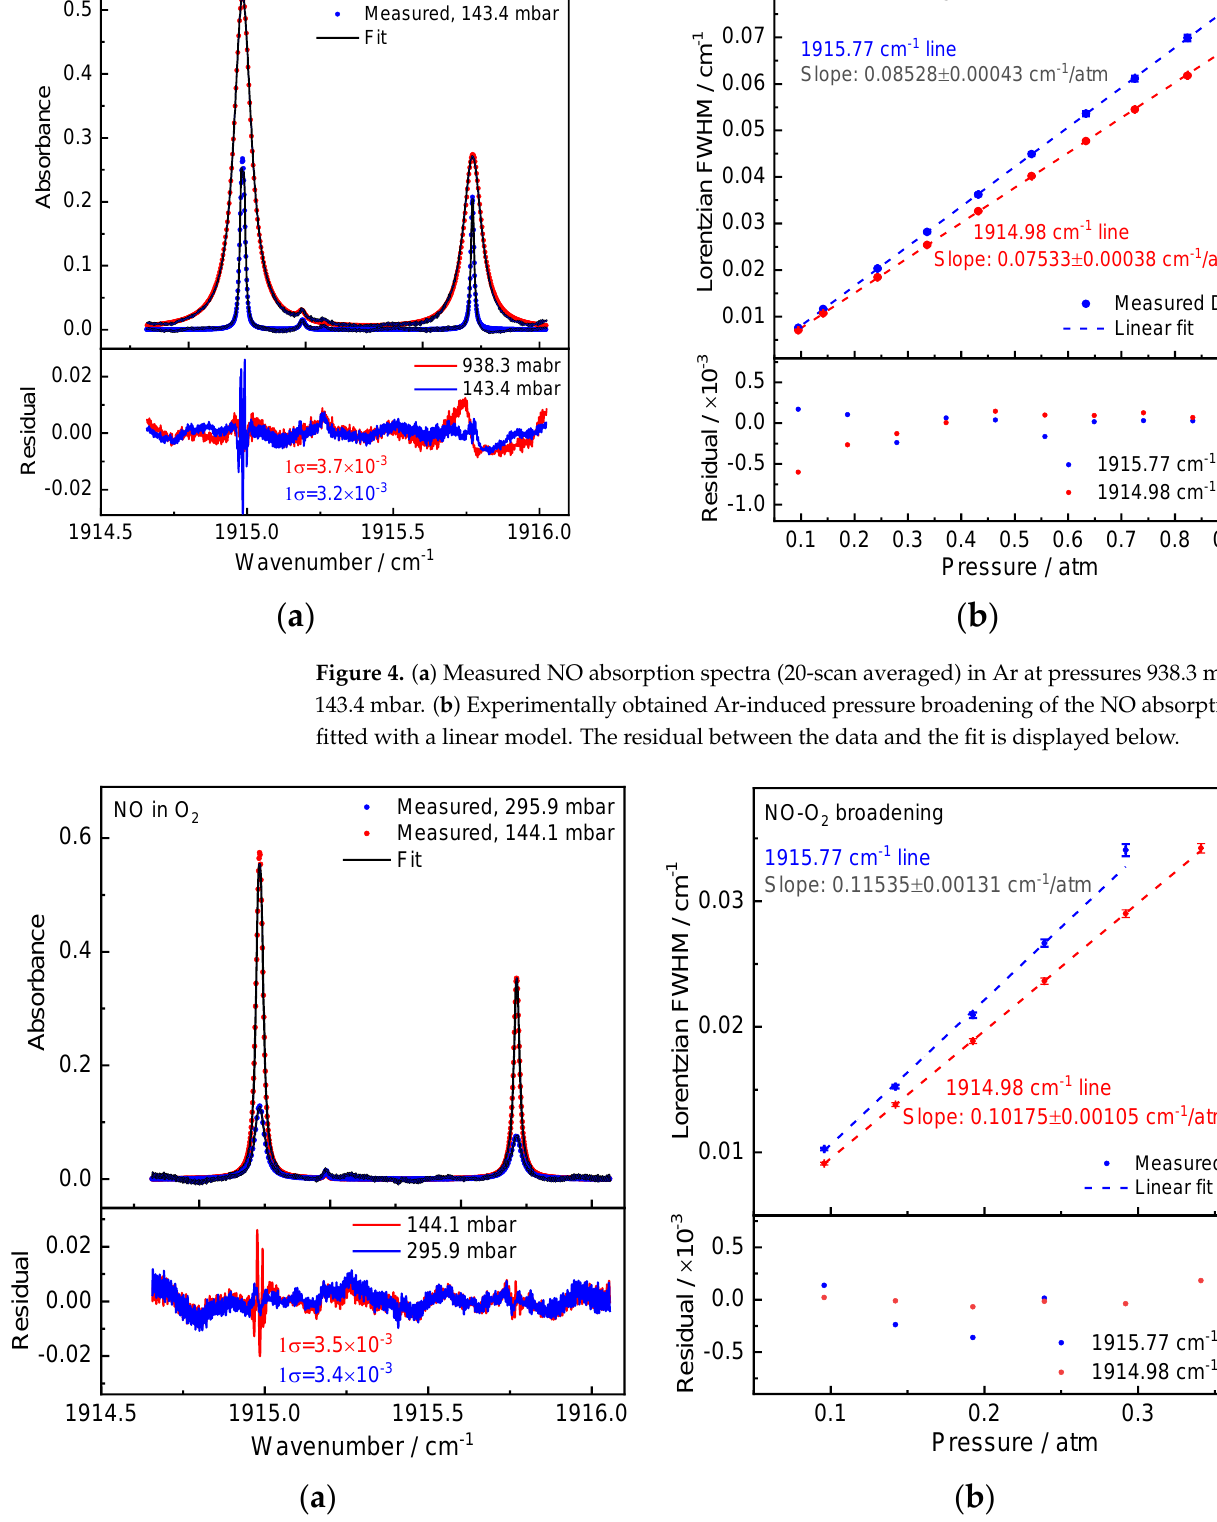
Figure 4. ( a ) Measured NO absorption spectra (20-scan averaged) in Ar at pressures 938.3 mbar and 143.4 mbar. ( b ) Experimentally obtained Ar-induced pressure broadening of the NO absorption lines fitted with a linear model. The residual between the data and the fit is displayed below.